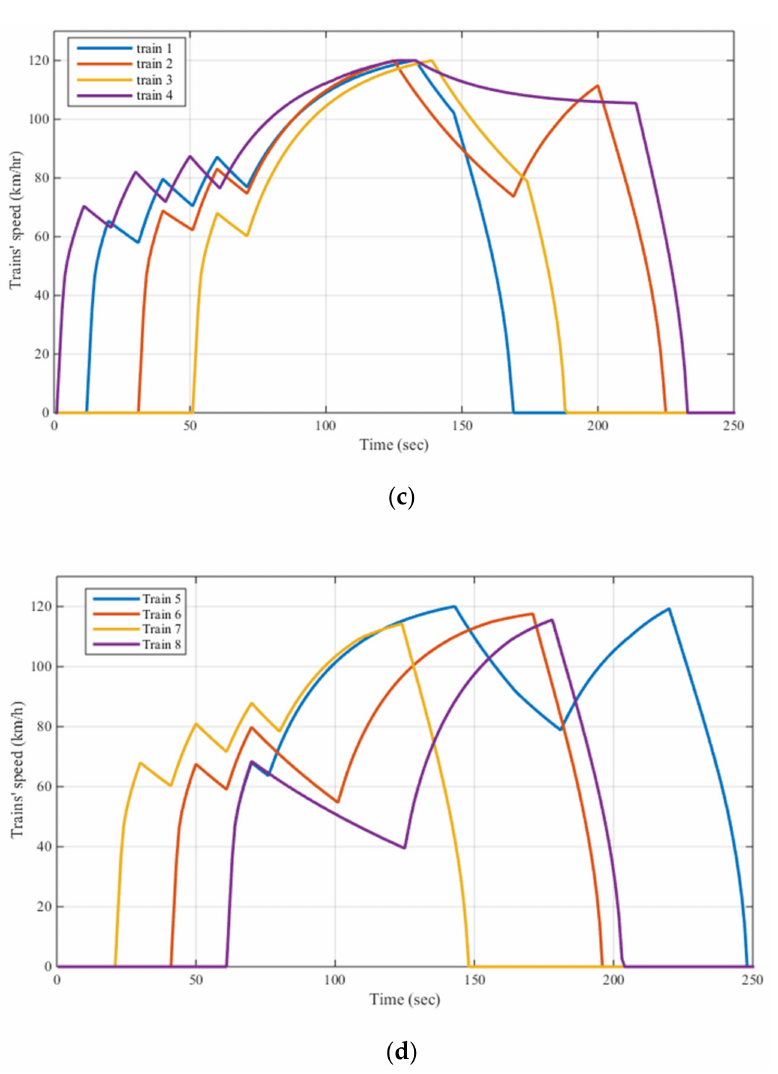
Figure 9. ( a , b ): timetable of trains moving on two opposite rail lines considered in the simulation; ( c , d ): speed profiles of the trains moving on two opposite rail lines.